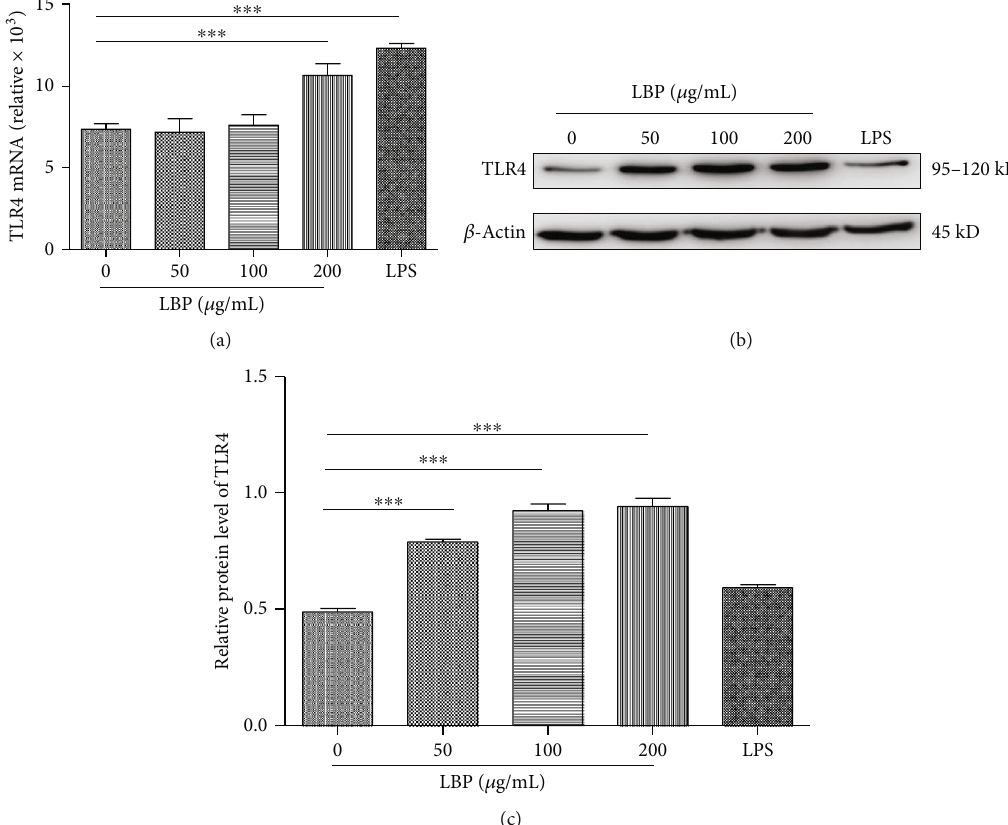
Figure 2: LBP improve TLR4 expression on the cell surface of DCs. DCs were stimulated for 30 min with LBP (0, 50, 100, and 200 μ g/mL) and LPS (100ng/mL), respectively. After stimulation, the cell RNA and protein were extracted; gene and protein expression of TLR4 was detected by Taqman-PCR (a) and Western blot (b) and (c) separately. Values are the mean and SD of 3 independent experiments. ∗ P < 0 : 05 , ∗∗ P < 0 : 01 , and ∗∗∗ P < 0 : 001 were considered statistically signi fi cant di ff erent from